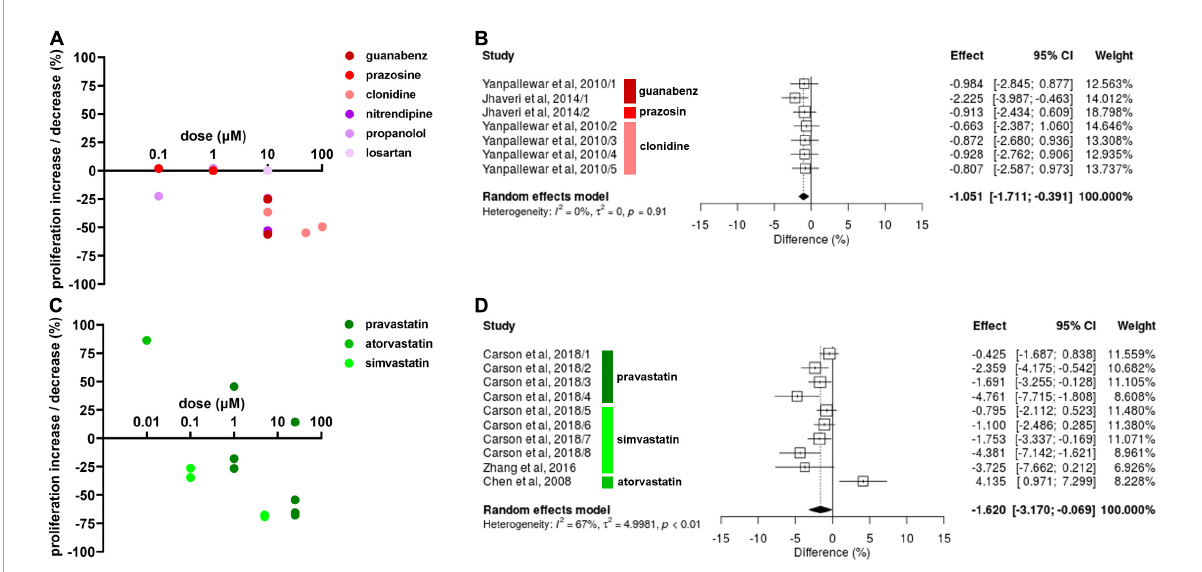
FIGURE2 Effect of antihypertensive drugs and statins on neural stem cell (NSC) proliferation. (A) Results include effects of α 2As (guanabenz, prazosin, and clonidine), calcium channel blockers (CCBs) (nitrendipine), beta blockers (BBs) (propranolol), and angiotensin 2 receptors antagonists (A2RA) (losartan) after 1–14 days exposure at varying doses. (B) Forest plot showing the effect sizes of experiments reporting the effect of α 2As guanabenz (10 µ M), prazosin (1 µ M), and clonidine (10, 50, and 100 µ M) on NSC proliferation. The overall effect was statistically significant ( p < 0.01). (C) Percentage increase/decrease in NSC proliferation after 3–7 days exposure of varying doses of statins compared to untreated controls. (D) A forest plot showing the range in effect sizes of experiments reporting the effect of statins pravastatin (1 and 25 µ M) atorvastatin (0.1 µ M), and simvastatin (0.1, 5, and 25 µ M) on NSC proliferation. There was a statistically significant effect ( p =